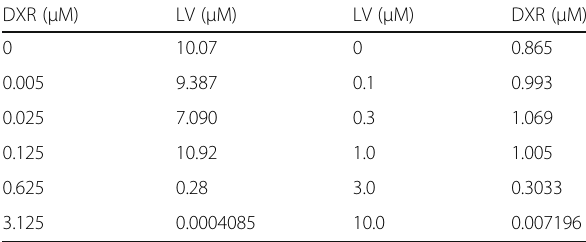
Table 2 DXR/LV in combination achieving 50% inhibitory